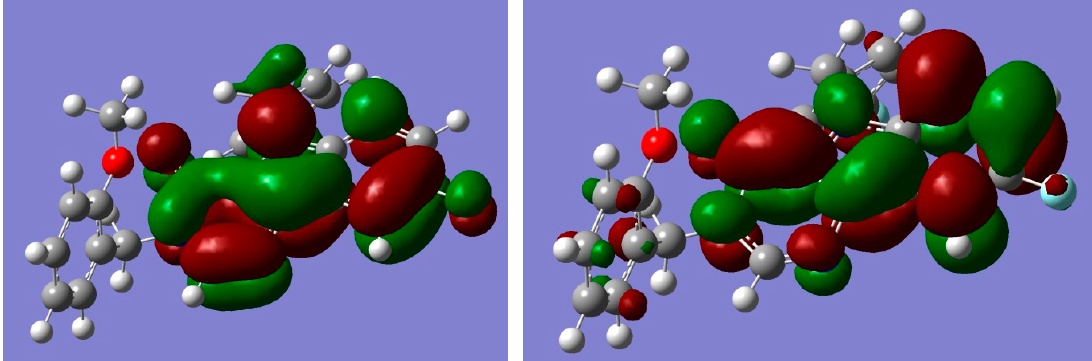
Figure 8. Graphical representation of frontier molecular orbitals (FMOs) of compound ( 3 ); left picture corresponds to highest occupied molecular orbital (HOMO), right—lowest unoccupied molecular orbital (LUMO).